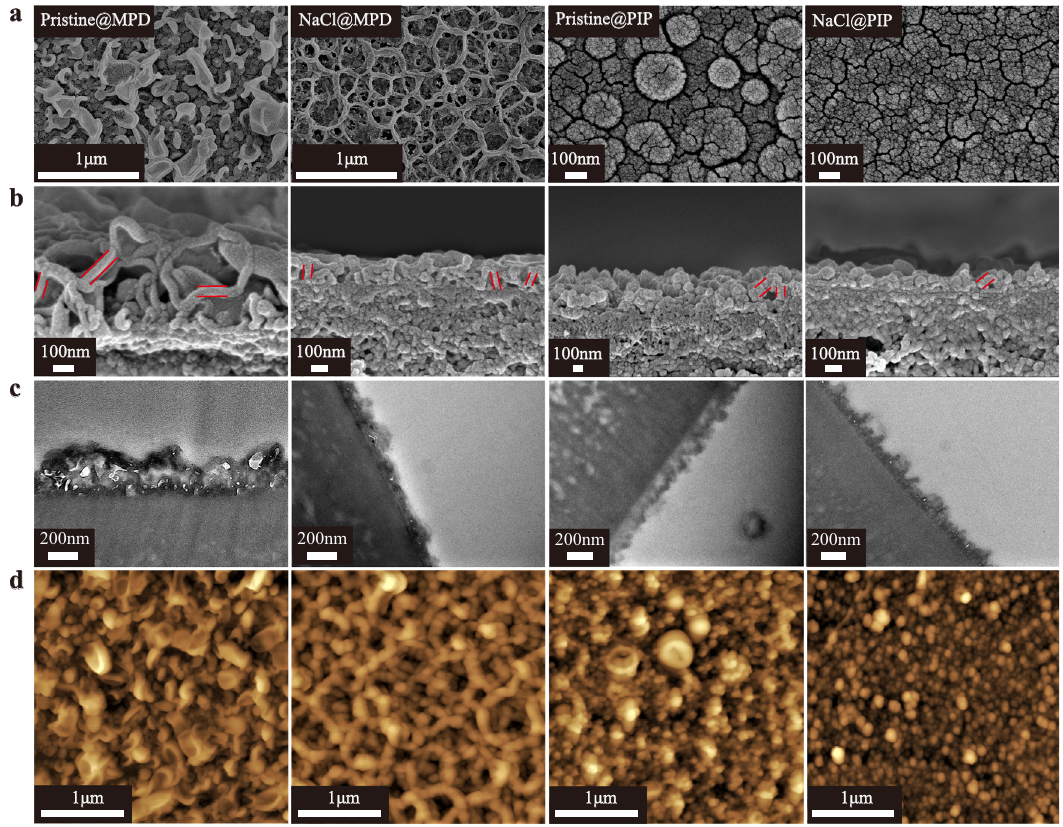
Fig. 4 Morphology and topology of the pristine and modi fi ed membranes. a Surface (scale bar: 1 μ m and 100nm) and b cross-sectional SEM images (scale bar: 100nm), c cross-sectional TEM images (scale bar: 200nm) and d topologic AFM images (scale bar: 1 μ m) of the pristine and modi fi ed